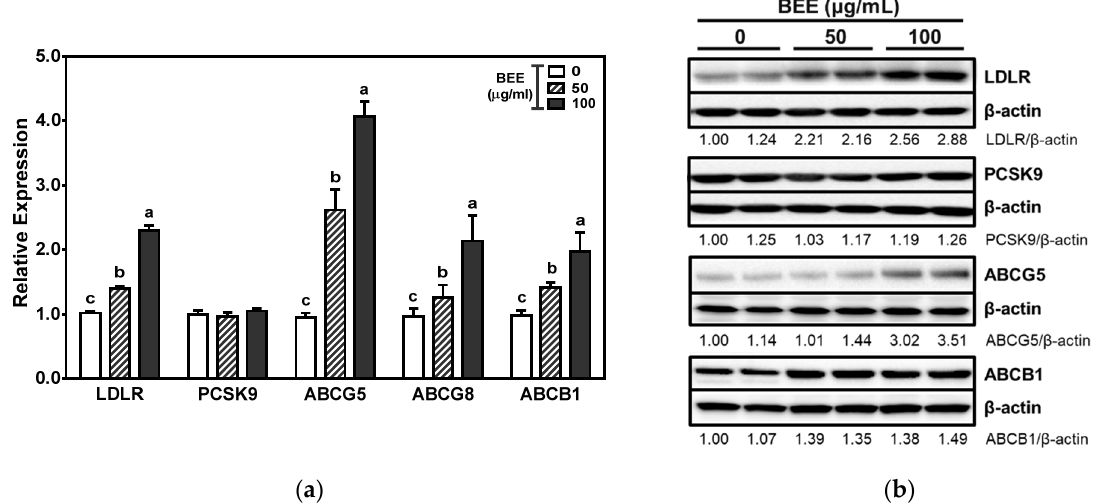
Figure 4. The effect of BEE on the genes involved in the transintestinal cholesterol excretion (TICE) pathway in Caco-2 cells. The cells were treated with 50 or 100 μ g/mL BEE for 24 h. ( a ) The mRNA abundance was measured by qRT-PCR analysis. Data are expressed as relative expressions to control. Bars with different letters are significantly different ( p < 0.05). Values are means ± SEM; n = 6. ( b ) The Western blot was conducted twice, and the representative image is shown. β -Actin was used as a loading control. The densitometry analysis was performed to measure the relative intensity, and the values are shown under each protein band.